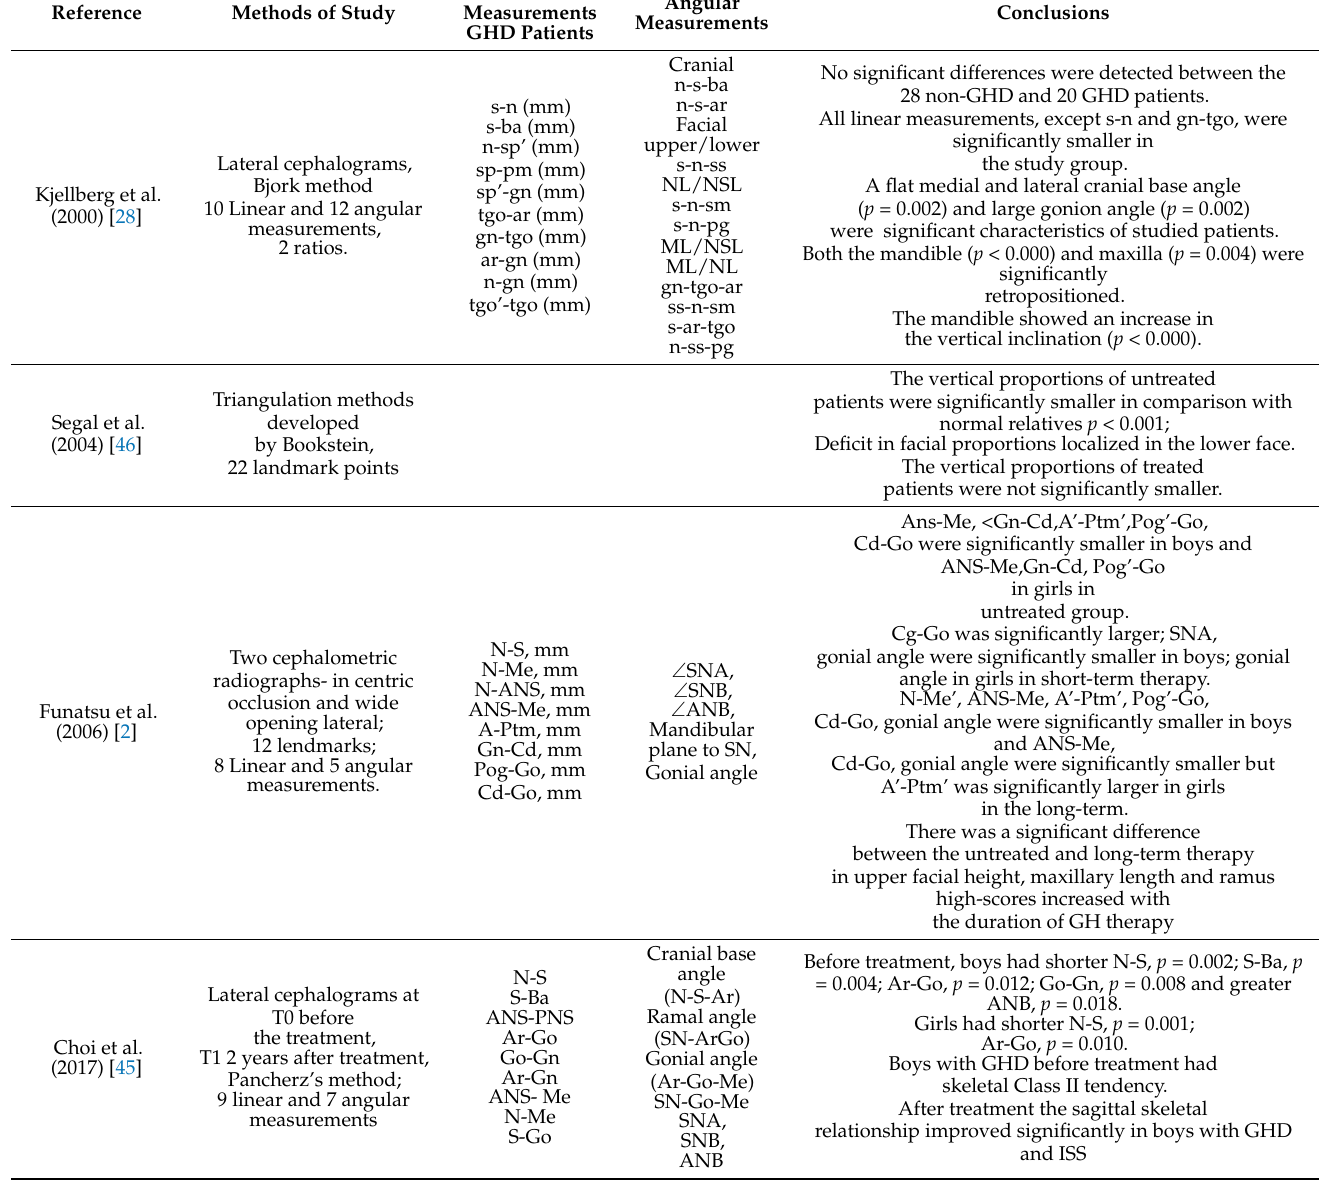
Table 4. Anthropometric craniofacial characteristics—data abstracted from studies included in systematic review.